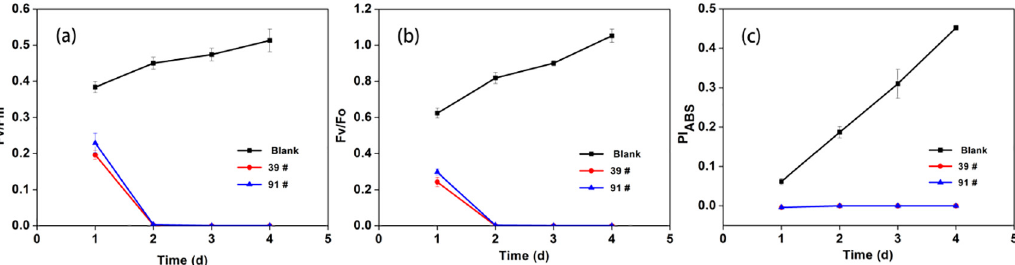
Figure 13. Effects of two bacterial strains on the chlorophyll fluorescence parameters of Microcystis aeruginosa. ( a ) Fv/Fm; ( b ) Fv/Fo; and ( c ) PI ABS ).